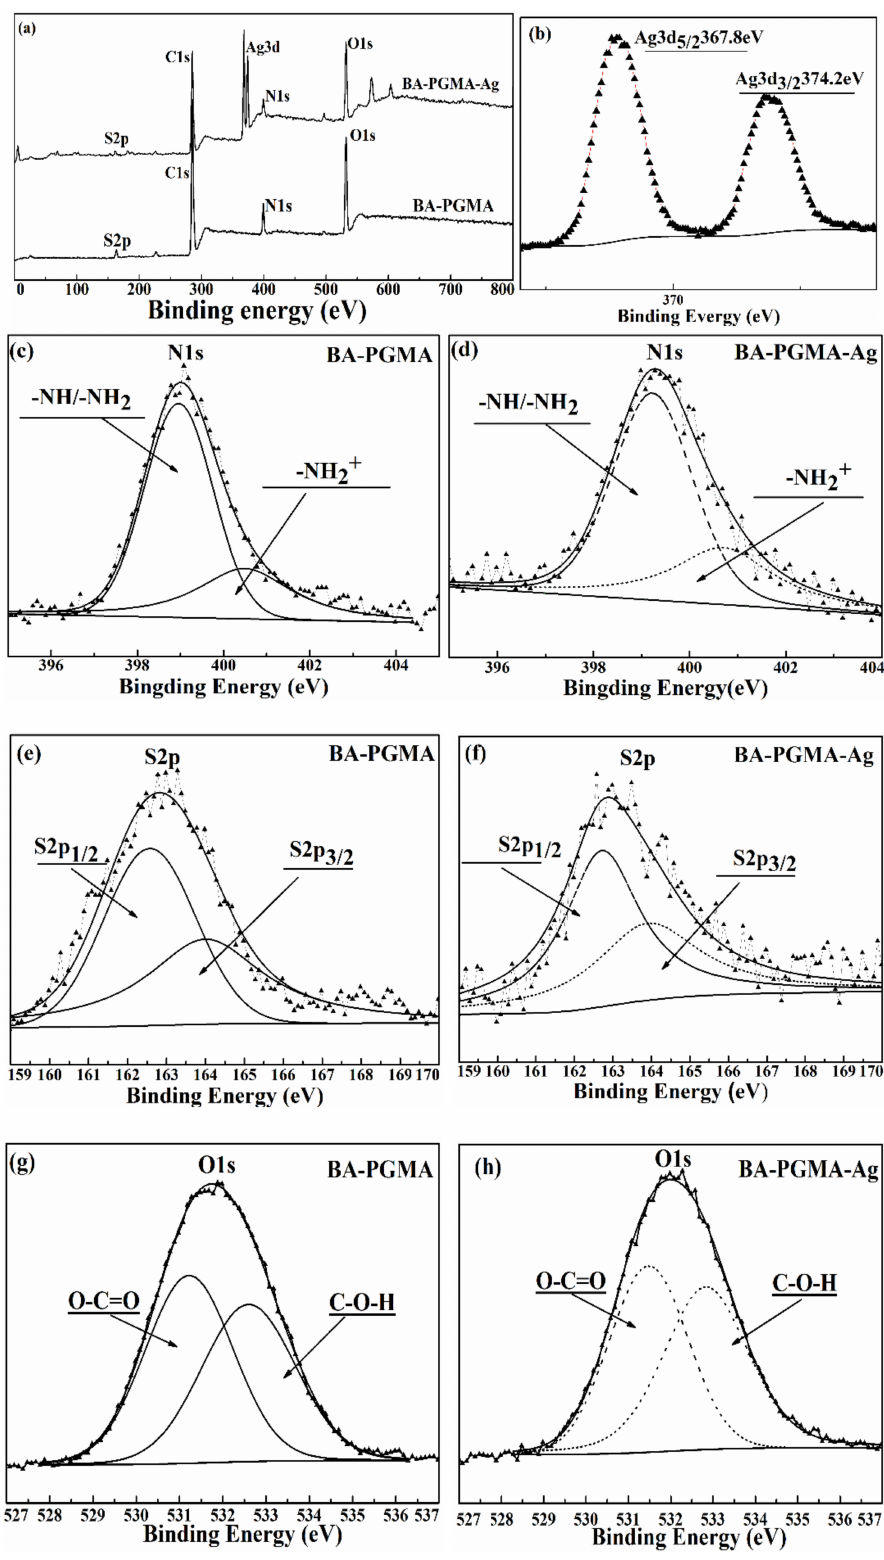
Figure 11. XPS survey scan spectra of BA-PGMA ( a ) and spectra of BA-PGMA-Ag ( b ), N1s spectra of BA-PGMA ( c ) and BA-PGMA-Ag ( d ), S2p spectra BA-PGMA ( e ) and BA-PGMA-Ag ( f ), O1s spectra BA-PGMA ( g ), and BA-PGMA-Ag ( h